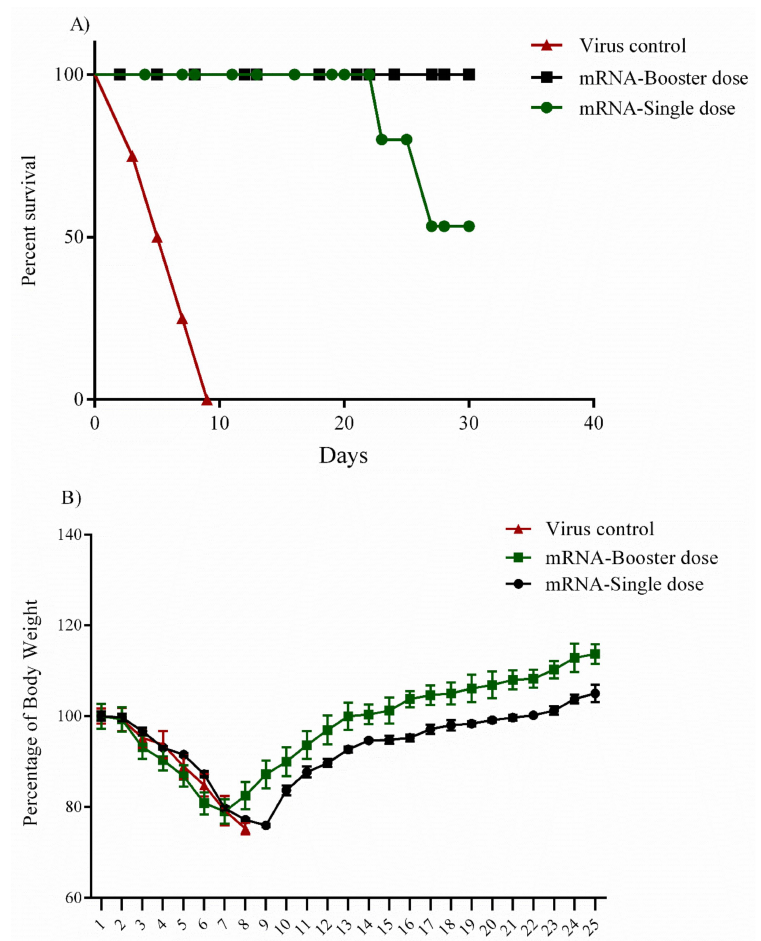
Figure 5. Challenge assay in IFN α / β / γ R − / − mice. ( A ) Percentage survival. A total of 12 female 8-12-week-old IFN α / β / γ R − / − mice in 3 groups of single, booster, and negative control were